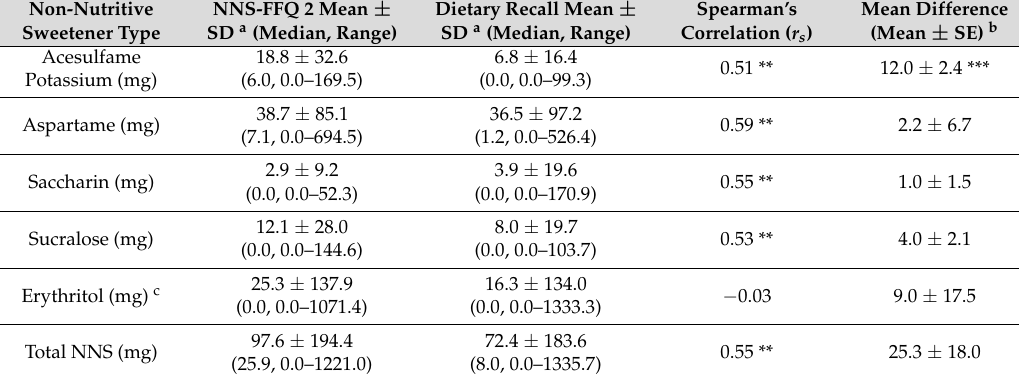
Table 4. Comparative validity of a non-nutritive sweetener food frequency questionnaire (NNS-FFQ) as compared to three 24-h dietary recalls ( n =